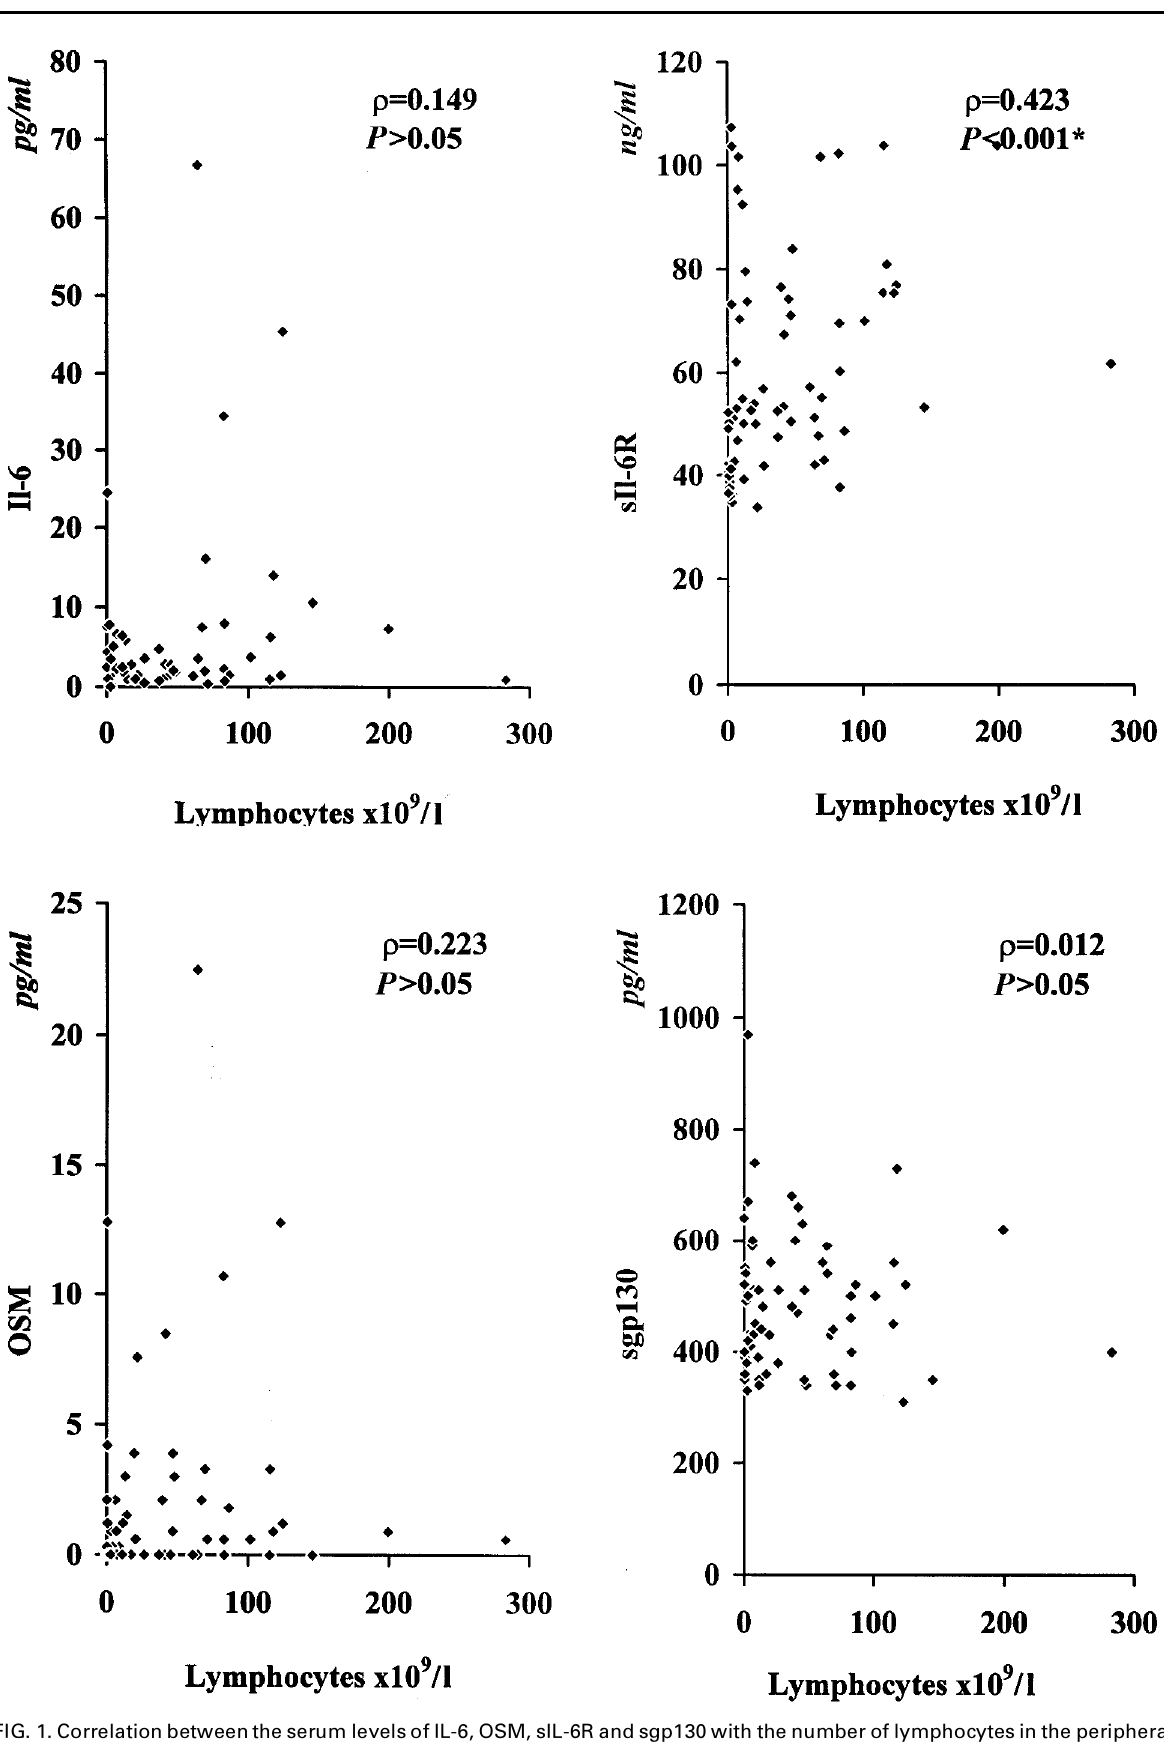
FIG. 1. Correlation between the serum levels of IL-6, OSM, sIL-6R and sgp130 with the number of lymphocytes in the peripheral blood of CLL